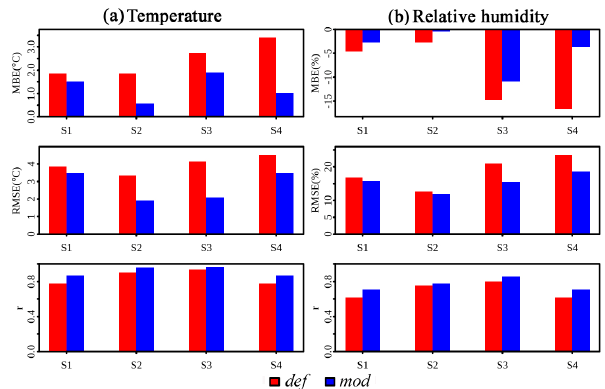
Figure 4. The mean bias error (MBE), root mean squared error (RMSE) and Pearson correlation coefficient (r) between the simulated and observed ( a ) air temperature and ( b ) relative humidity at 2 m at the four stations (S1, S2, S3 and S4).